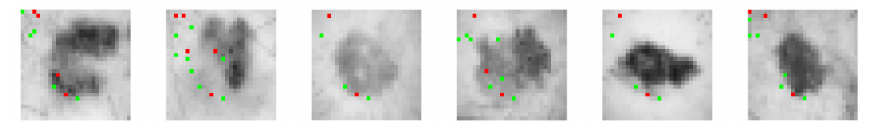
Figure 16. Centroids of nine rules with their antecedents generated from R 17 in the fully connected layers.